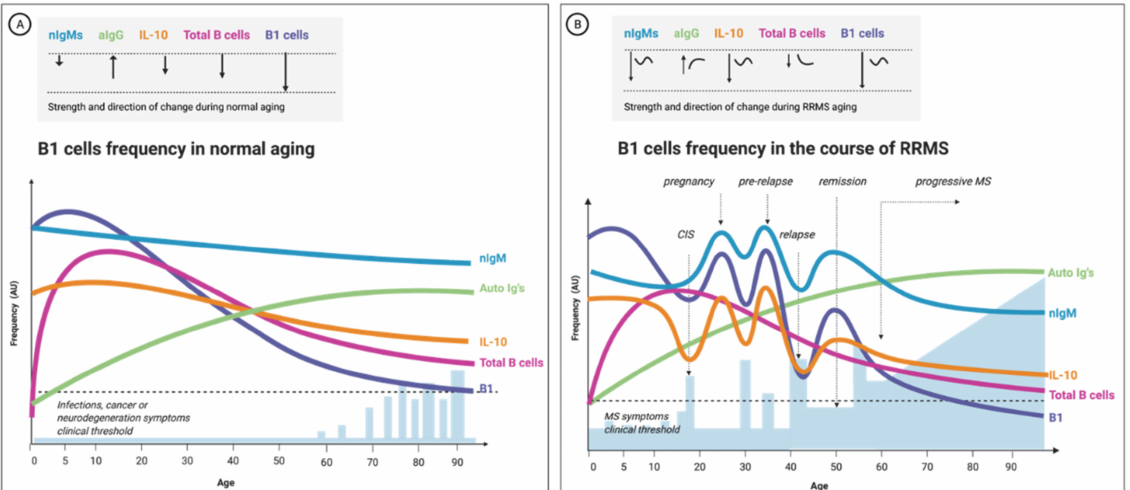
Figure 5. The change in B1-cell frequency during normal aging and remitting-relapsing multiple sclerosis (RRMS)-proposed model based on current empirical evidence. B1-cell frequency is positively correlated to the number of natural antibodies and inversely correlated to the levels of IL-10 in the blood. In ( A ), the frequency has a linear trend: the B1-cell count declines with aging proportionally to the total B-cell population (all B cells subtypes). ( B ) shows the expected change in the frequency of B1 cells during aging of a female RRMS patient; here, the fluctuations are more accentuated, the onset time of the change differs, and the trend is often nonlinear. Moreover, the change in B1-cell frequency and serum IL-10 correlate to the clinical picture (B1-cell numbers increase before an attack and decline thereafter): nIgM, natural IgMs antibodies; aIgs, autoreactive antibodies (mostly class-switched IgGs); total B cells, the total B lymphocytes and B1-cell- frequency in the peripheral blood circulation; CIS, clinically isolated syndrome; blue bars represent relapse episodes; the dashed line depicts the threshold for clinical symptoms manifestations; AU, arbitrary